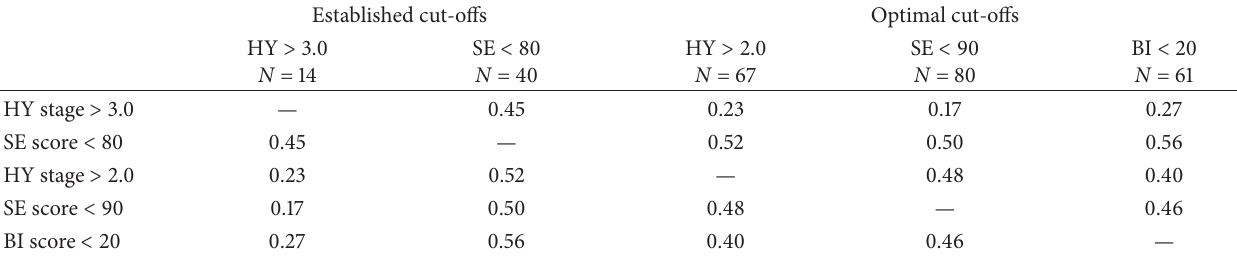
Table 3: Concordance (kappa values) between independence assessment tools at different cut-off values. Established